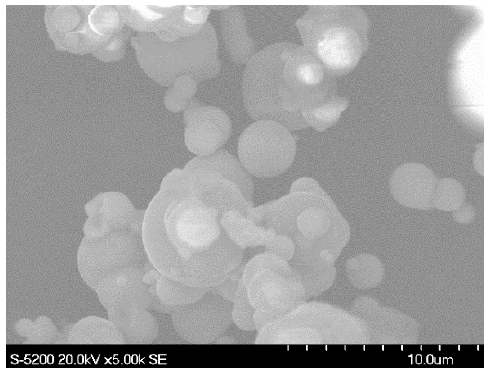
Figure 1. SEM picture of the magnetic particles.